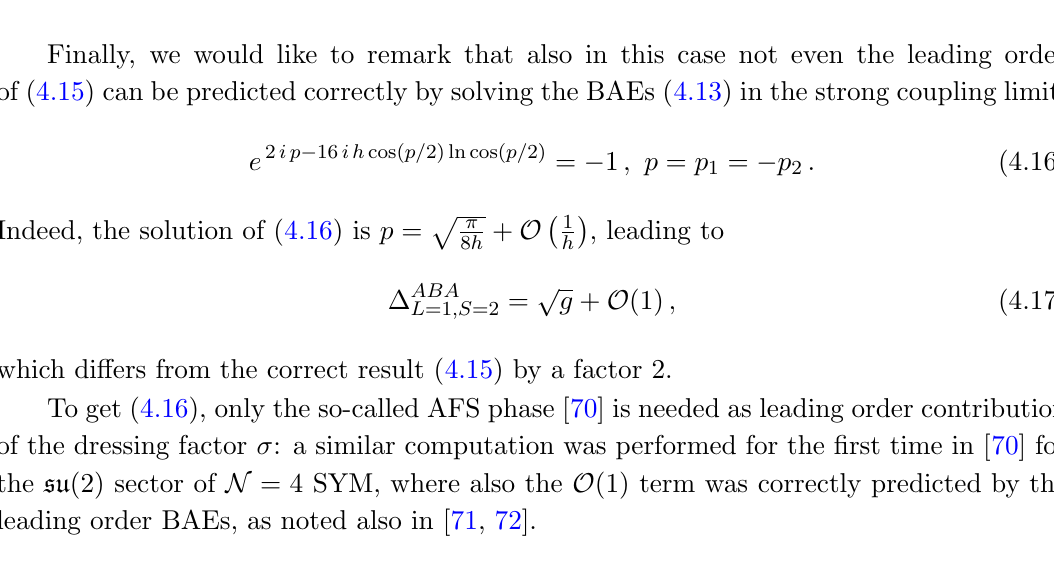
Table 3 . Strong coupling coe(cid:14)cients for L = 1 ; S =